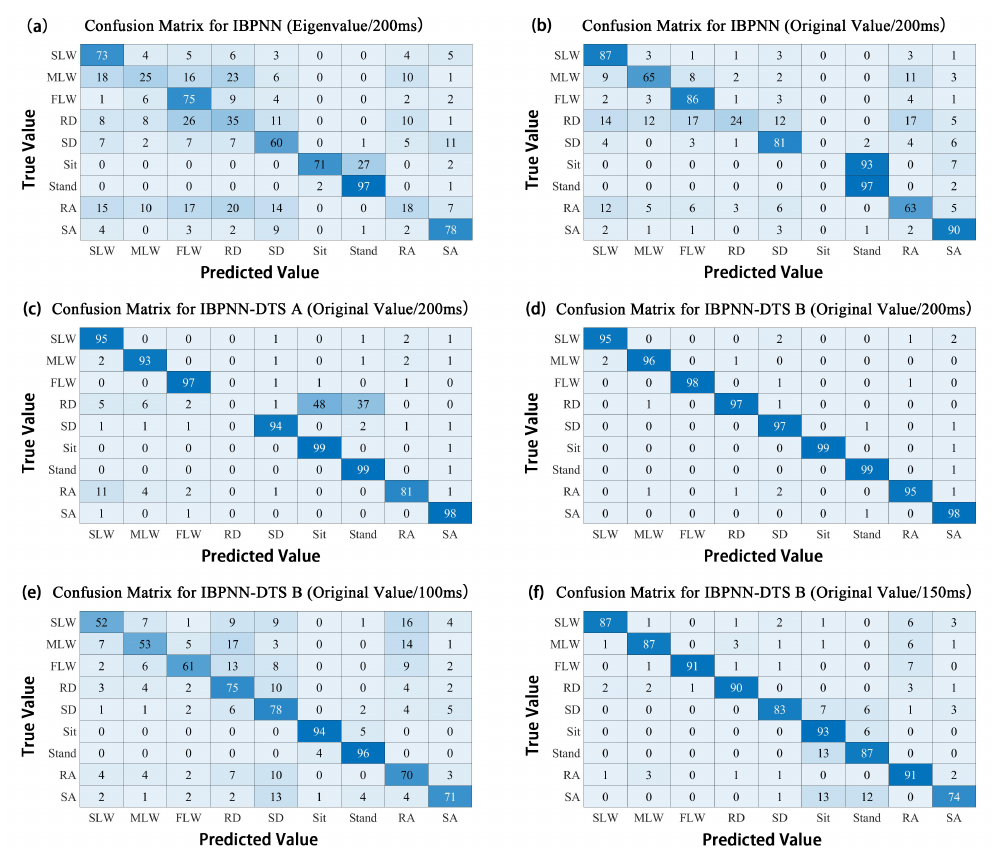
Figure 5. Confusion matrix for different inputs (all values are